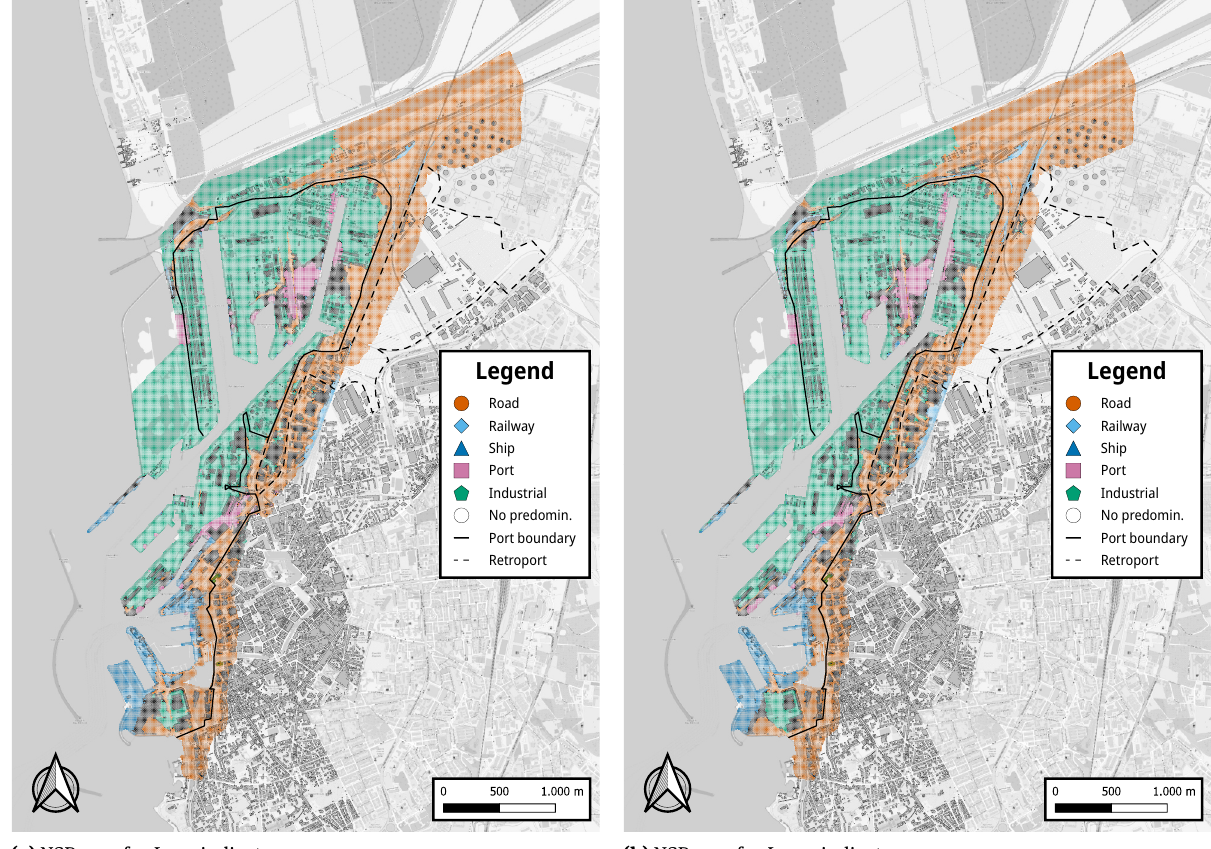
Figure 6: Noise Source Predominance map of the port of Livorno for L DEN and L Night indicators.